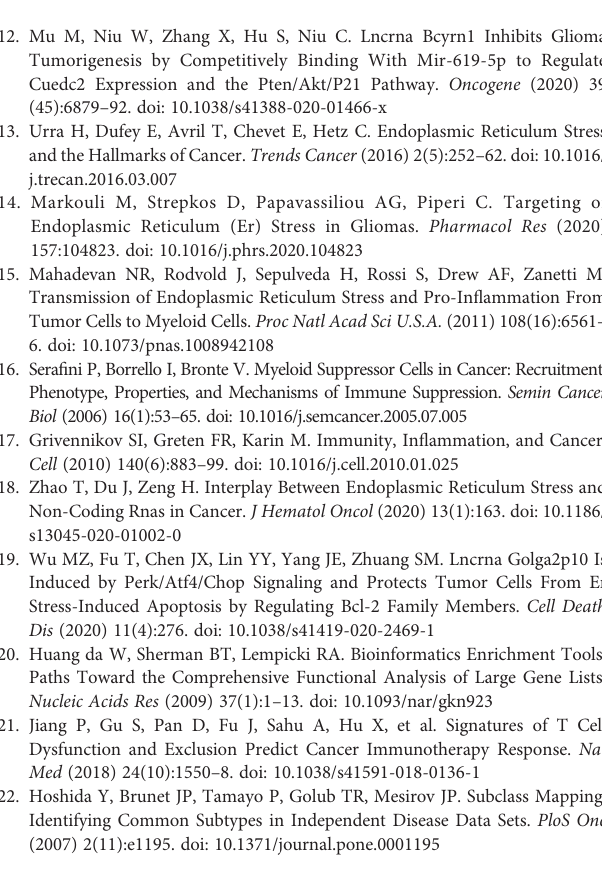
Supplementary Figure 1 | | Clinical and molecular characteristics in consensus clustering subgroups of gliomasin the testing group. (A) Consensus clustering CDF for k = 2 to 9. (B) Of the length and slope of the CDF curve as the index changes from 2 to 9. (C) Consensus matrix for the two groups from the CGGA database